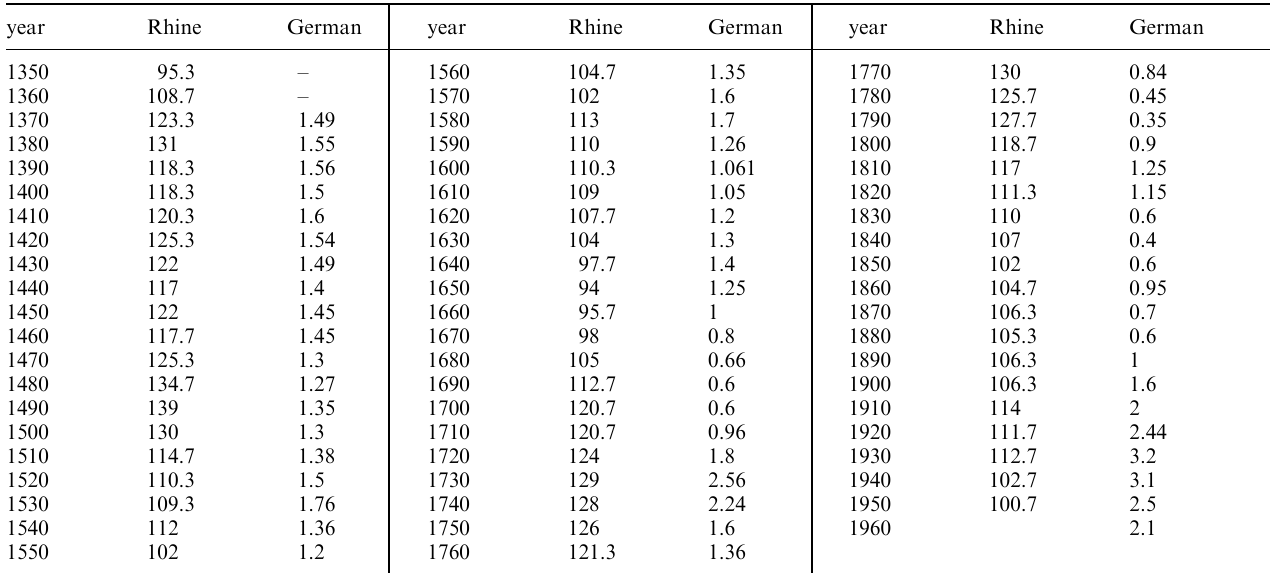
Table 6. Tree-ring data